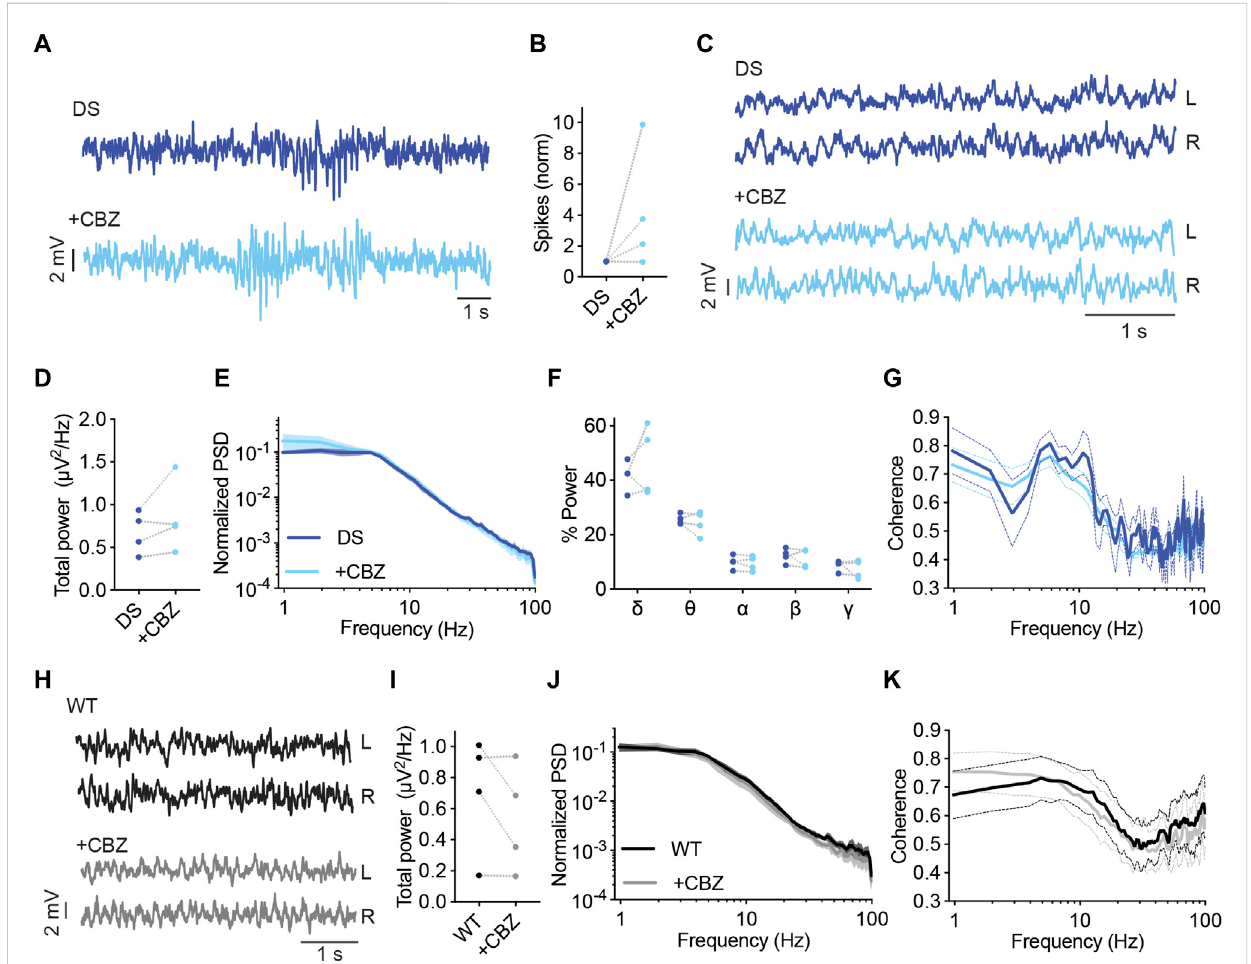
FIGURE 6 CBZ increased the frequency of interictal spikes in most DS mice. (A) Representative traces of epileptic activity in DS mice before and after acute administration of CBZ (20 mg/kg). (B) The effect of CBZ on interictal spike frequency. (C) Representative traces of background ECoG in DS mice before and after treatment with CBZ. (D) The effect on total power. (E) ECoG power density pro fi les normalized to the absolute total power prior to drug administration. (F) The relative power in each frequency band. (G) Interhemispheric coherence plotted over the 1 – 100 Hz spectrum. DS, n = 4. (H) Representative traces of background ECoG from WT mice, before and after administration of CBZ. (I) The effect of CBZ on total power. (J) ECoG power density pro fi les normalized to the absolute power prior to drug administration. (K) Interhemispheric coherence plotted over the 1 – 100 Hz spectrum. WT, n =